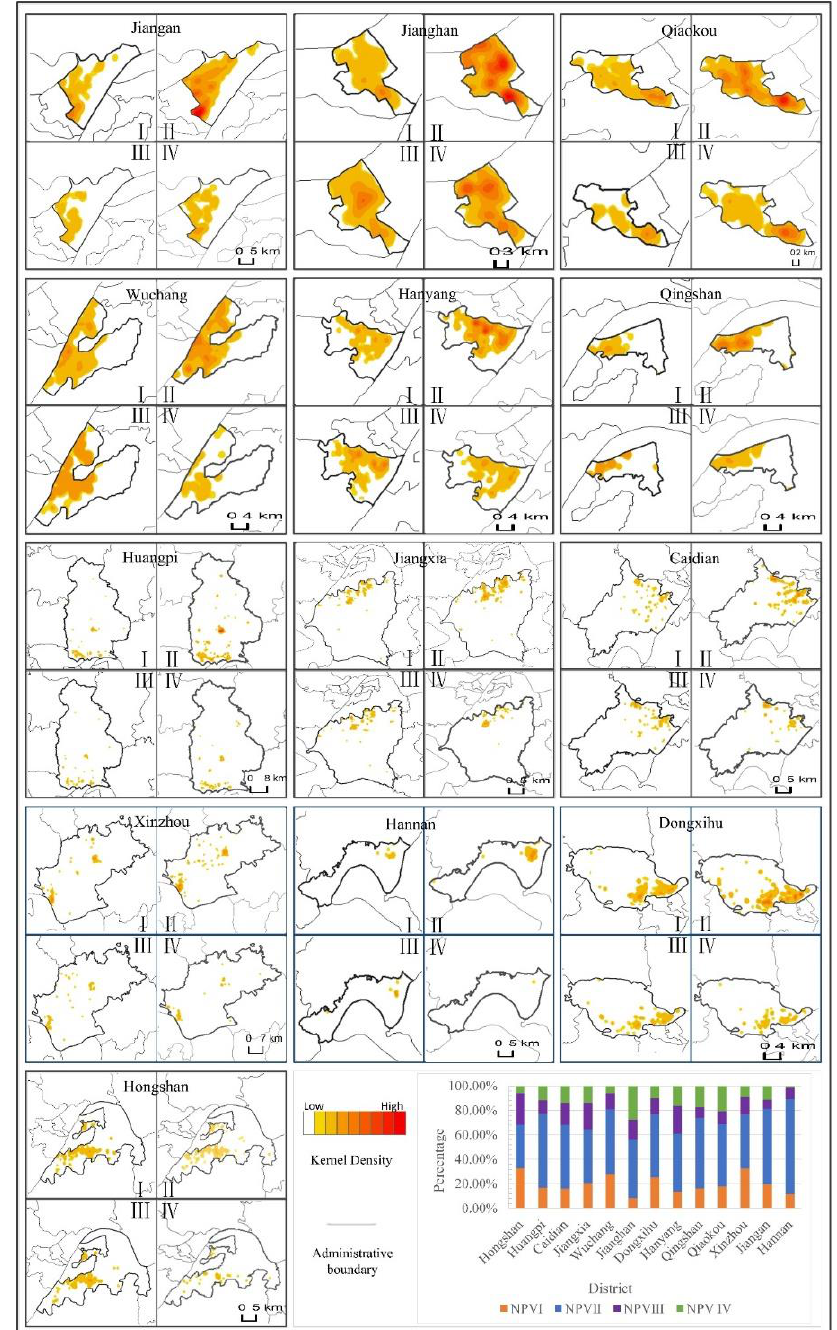
Figure 4. Kernel density and percentage of residential areas with different levels of NVP in each administrative district of Wuhan.